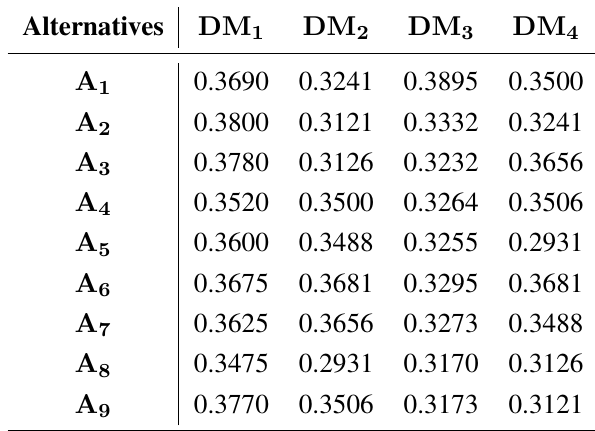
Table 8. Overall score matrix with the Min-Max model.